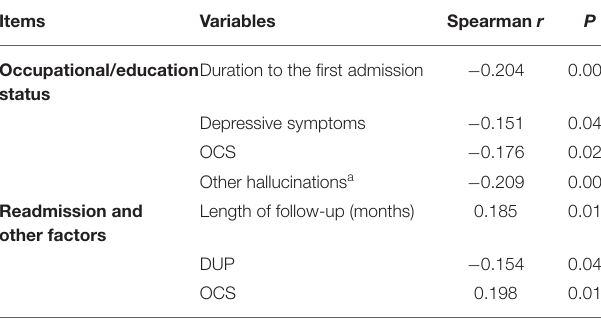
TABLE 5 | Spearman correlation of COS outcomes and other factors.